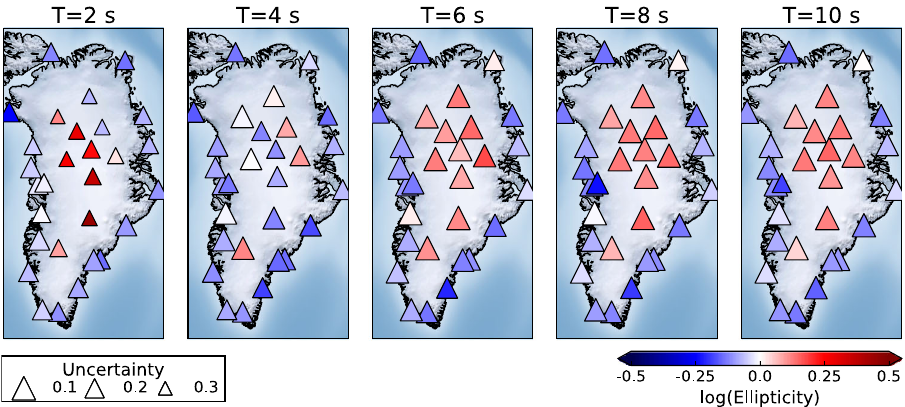
Fig. 4 Summary of ellipticity measurements for all stations as a function of period in 2015 with a DOP ≥ 0.95. The colours represent the ellipticity while the size of the triangle represents the uncertainty of each